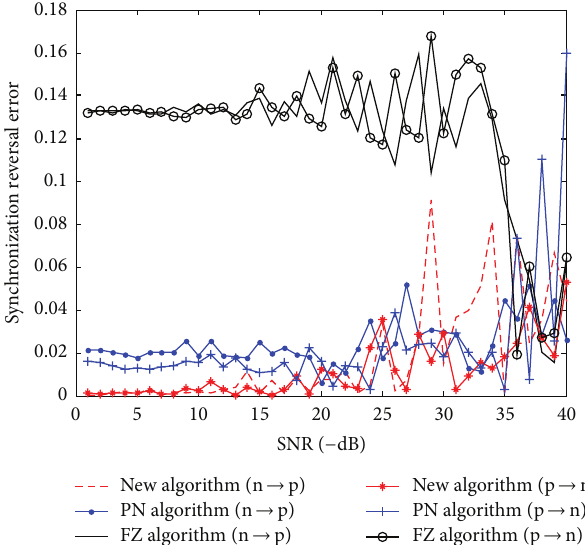
Figure 8: The estimated reversal errors comparison with changing data reversal rate.